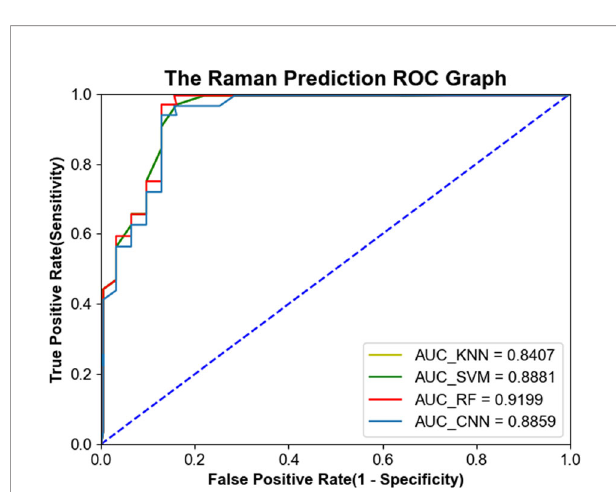
FIGURE 6 | ROC curves of serum Raman spectra generated from four machine learning models, including one-dimensional convolutional neural network (1D-CNN), random forest (RF), support vector machine (SVM), and K-nearest neighbor (KNN).